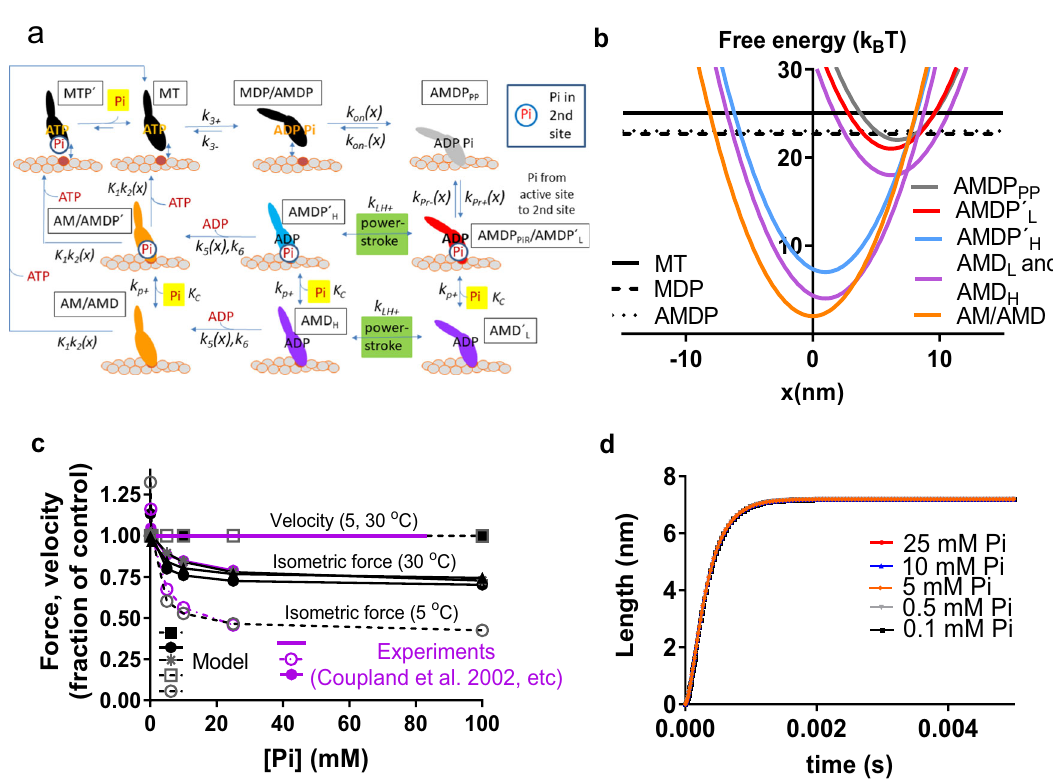
Fig. 4 | A mechanokinetic model incorporating a secondary Pi-binding site outside the active site. a A kinetic scheme with Pi-binding outside the active site, as indicated by circles in the second row. The Pi-dissociation rate constant ( k P+ ) from the AMDP´ L , AMDP´ H and AM/AMDP´ states (blue, red and orange in the middlerow)tothe AMD L ,AMD H and AM/AMD statesandthe reverse second order associationrateconstant k P − ´arerelatedas K C = k P + / k P − ´.Thus,apseudo- fi rst-order Pi-association rate constant, k P − = k P + [Pi] / K C applies for a given Pi-concentration. Short notations for states, as also used in Fig. 4b and elsewhere, are indicated in boxes. b Thefreeenergyvsthecross-bridgestrainvariable x forcriticalstatesofthe modelat0.5mMPi.ThePiintheAMDP´ L ,theAMDP´ H ,andthe(AM/AMD)P´states